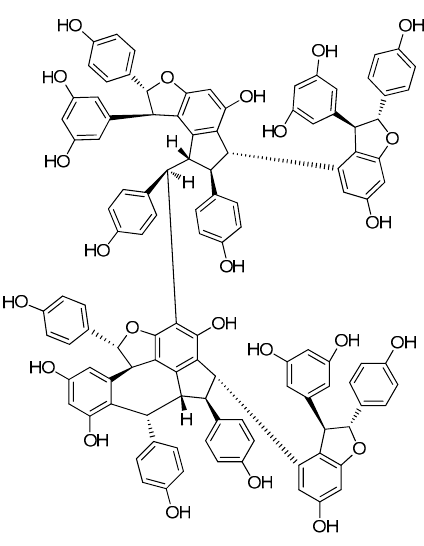
Figure 8. The structure of resveratrol octamer ( 92 ).